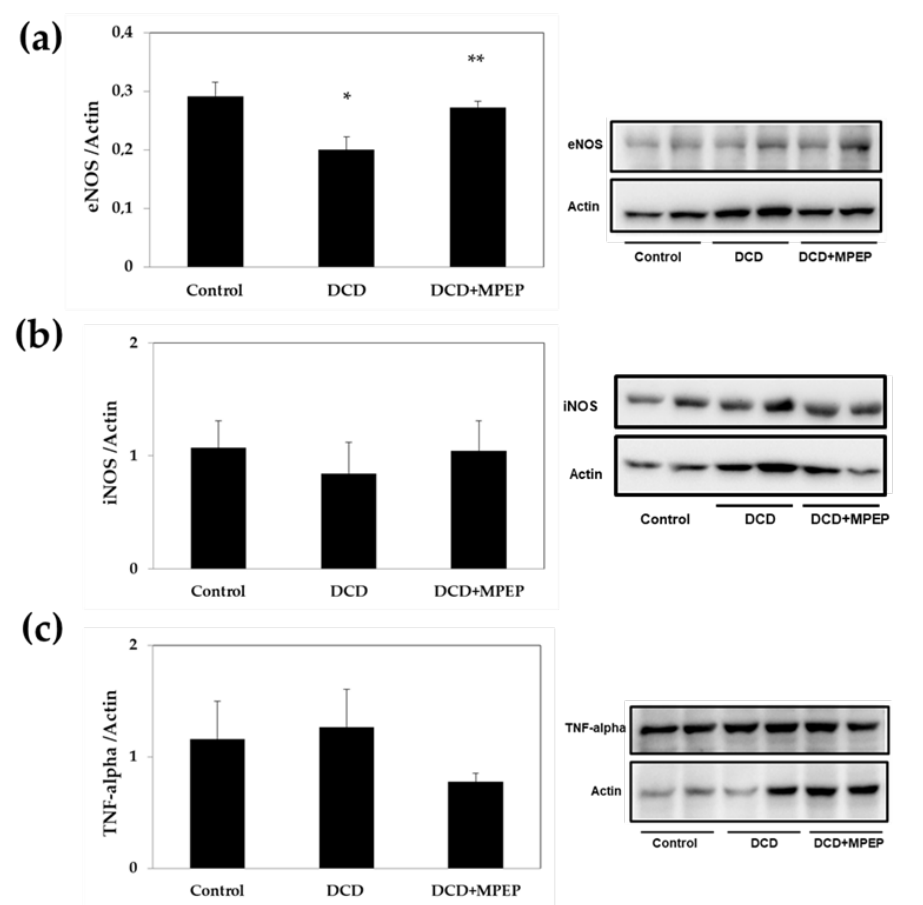
Figure 1. MPEP treatment increases eNOS levels in DCD livers during cold storage. ( a ) eNOS, ( b ) iNOS, and ( c ) TNF-alpha were determined in livers stored for 22 h in UW solution. Control animals underwent cold storage; in the cardiac-death-donor (DCD) group, the livers, after 30 min warm ischemia, were submitted to cold storage. In the DCD-MPEP group, the drug (10 mg/Kg) was administered 30 min before the portal clamping and added to the UW-solution (3 µM). The results are reported as the mean ±SE. * p < 0.05 versus control; ** p < 0.05 versus DCD.